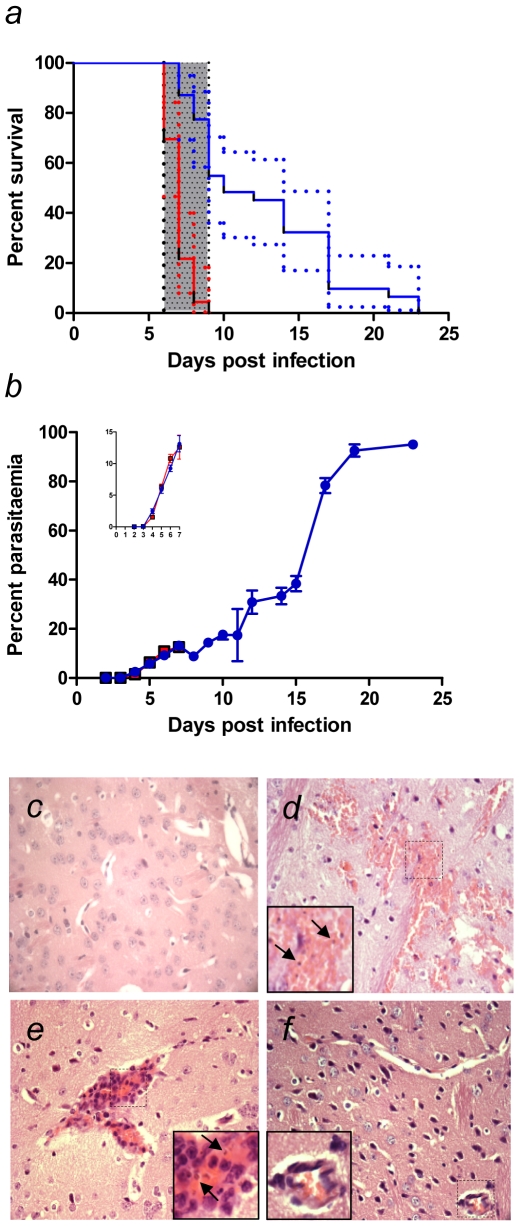
AC treatment for experimental cerebral malaria.
a) C57BL/6 mice were infected with PbA and either untreated (red line) or treated at d3 and d5 with oAC (Blue line). Survival was monitored over a 25 day period. The window for CM deaths (d6-9) is indicated by the hatched bar. Data are pooled from 5 independent experiments (n =  23 untreated and n =  31 oAC-treated mice) and are shown with 95% CI (dotted lines). Overall survival was significantly improved by oAC treatment (p<0.0001). b) Parasitemias in mice infected with PbA (open squares) and in PbA-infected mice treated with oAC (closed squares) are shown. Data represent mean ± SEM. Insert shows parasitemias over d1-7, enlarged for clarity. c–f) Brain histopathology of normal mice (c), mice infected for 6 days with PbA (d, e), and mice infected with PbA and treated with oAC (f). In d) and e), inserts show regions of perivascular hemorrhage and parasitized RBC (arrows). H&E staining; original magnification ×40.